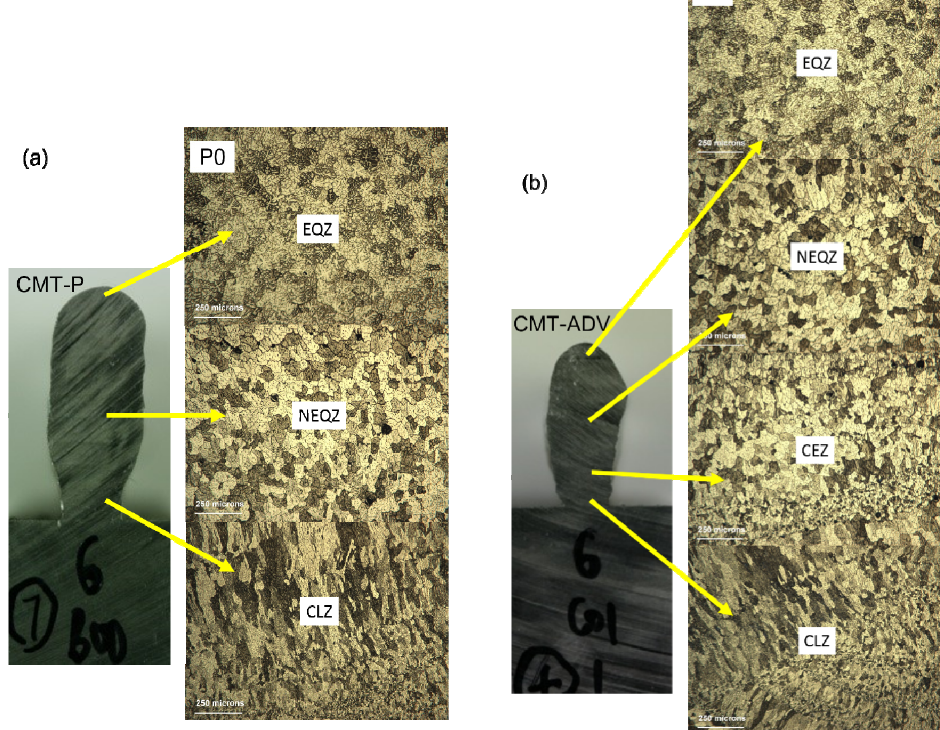
Figure 9. The microstructures of thin wall samples. ( a ) Sample P0; ( b ) sample A0.